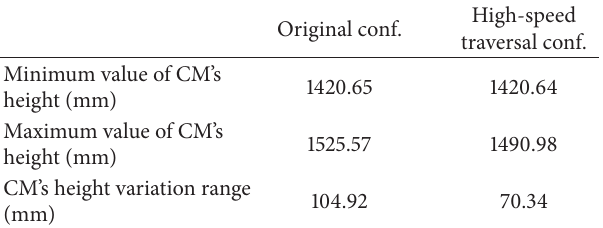
Table 2: Data from the CM’s vertical position variation. Original conf. traversal